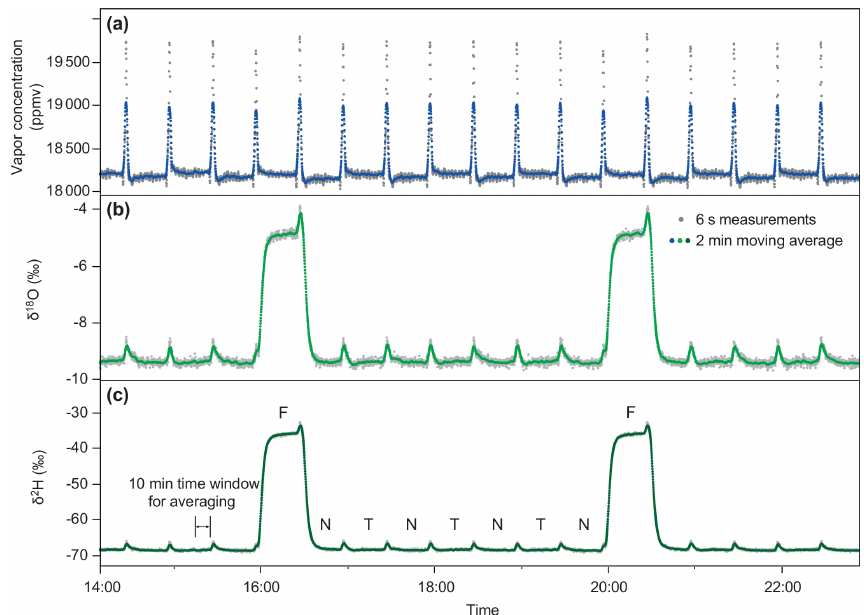
Figure 3. A 9h excerpt showing the raw, uncalibrated data of vapor concentrations (panel a ) and isotope measurements (panels b and c ) in tap water (T), nanopure water (N), and Fiji bottled water (F) during the 48h laboratory experiment. The samples were injected alternately with two Dosinos for 30min each at a flow rate of 1mLmin − 1